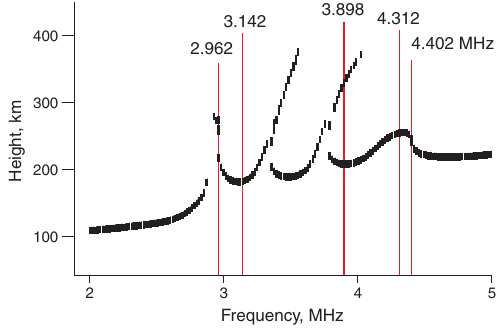
Figure 7. Enlarged synthesized ionogram with maximum density perturbation of 4%. Individual rays with various initial elevation angles were analyzed at the frequencies denoted by the vertical red lines and are shown in Figs. 8 to 11.